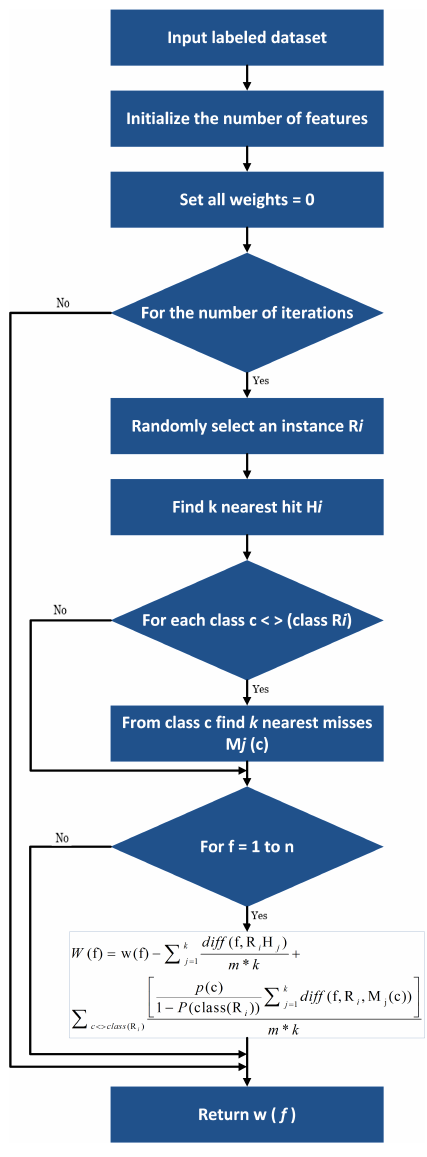
Figure 6. Flow chart of Feature Reduction Layer.